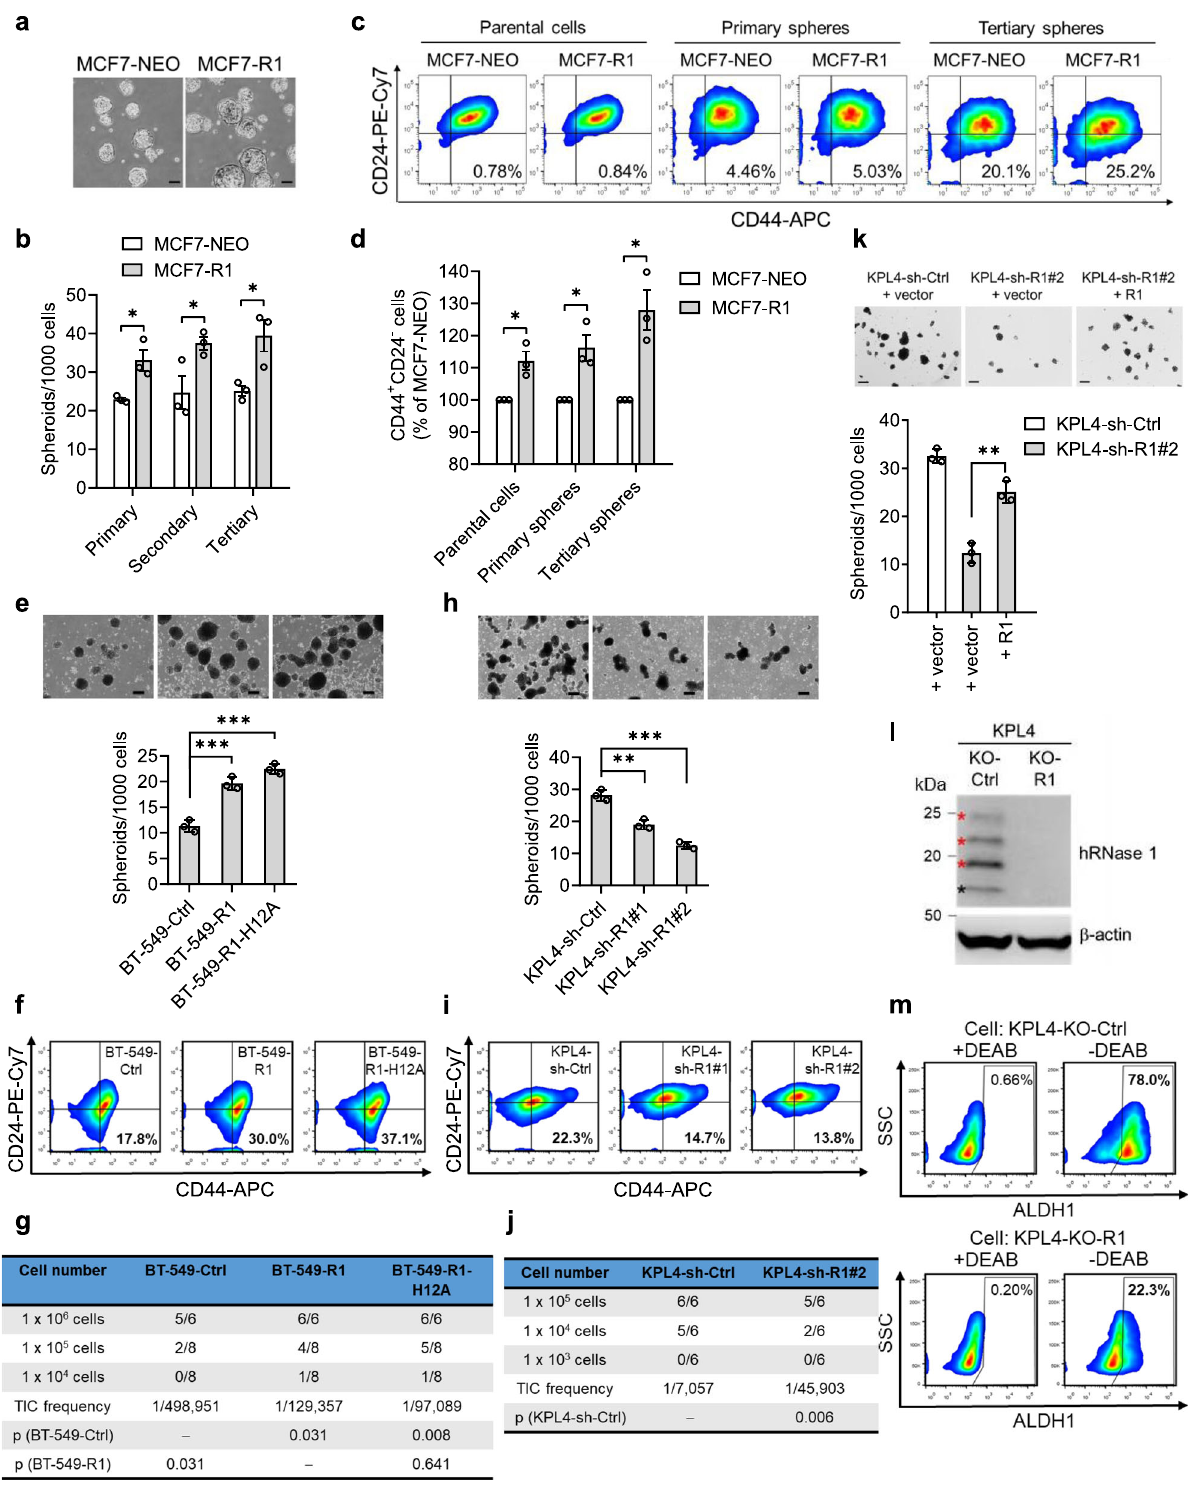
protein puri fi ed from Escherichia coli (Fig. 3h) and HEK293 cells hRNase 5 as a comparison, in line with the previous results from (Fig. 3i, j) by puri fi ed N-terminal EphA4 chimera (N-EphA4-Fc). phospho-RTK antibody array indicating that hRNase 5 as an Notably, numerous PLA signals were solely detected by anti- EGFR ligand induces phosphorylation of EGFR but not other EphA4 and anti-Flag antibodies in the recipient BT-549 and RTKs 14 . Considering hRNase 1 as a N -linked glycosylated protein 5 – 7 , we performed in vitro binding assay by incubating N- KPL4 cells treated with the CM containing Flag-tagged hRNase 1 EphA4-Fc with recombinant hRNase 1 protein produced from (293T-pCDH-R1), but not the CM containing Flag-tagged HEK293 cells, which we pretreated with glycosidase PNGase F hRNase 5 (293T-pCDH-hRNase 5) (Fig. 3f). These results sug- (Fig. 3i), and found that non-glycosylated hRNase 1 still harbored gested that EphA4 is in close proximity to hRNase 1 but not NATURE COMMUNICATIONS| (2021) 12:2788 |https://doi.org/10.1038/s41467-021-23075-2|www.nature.com/naturecommunications